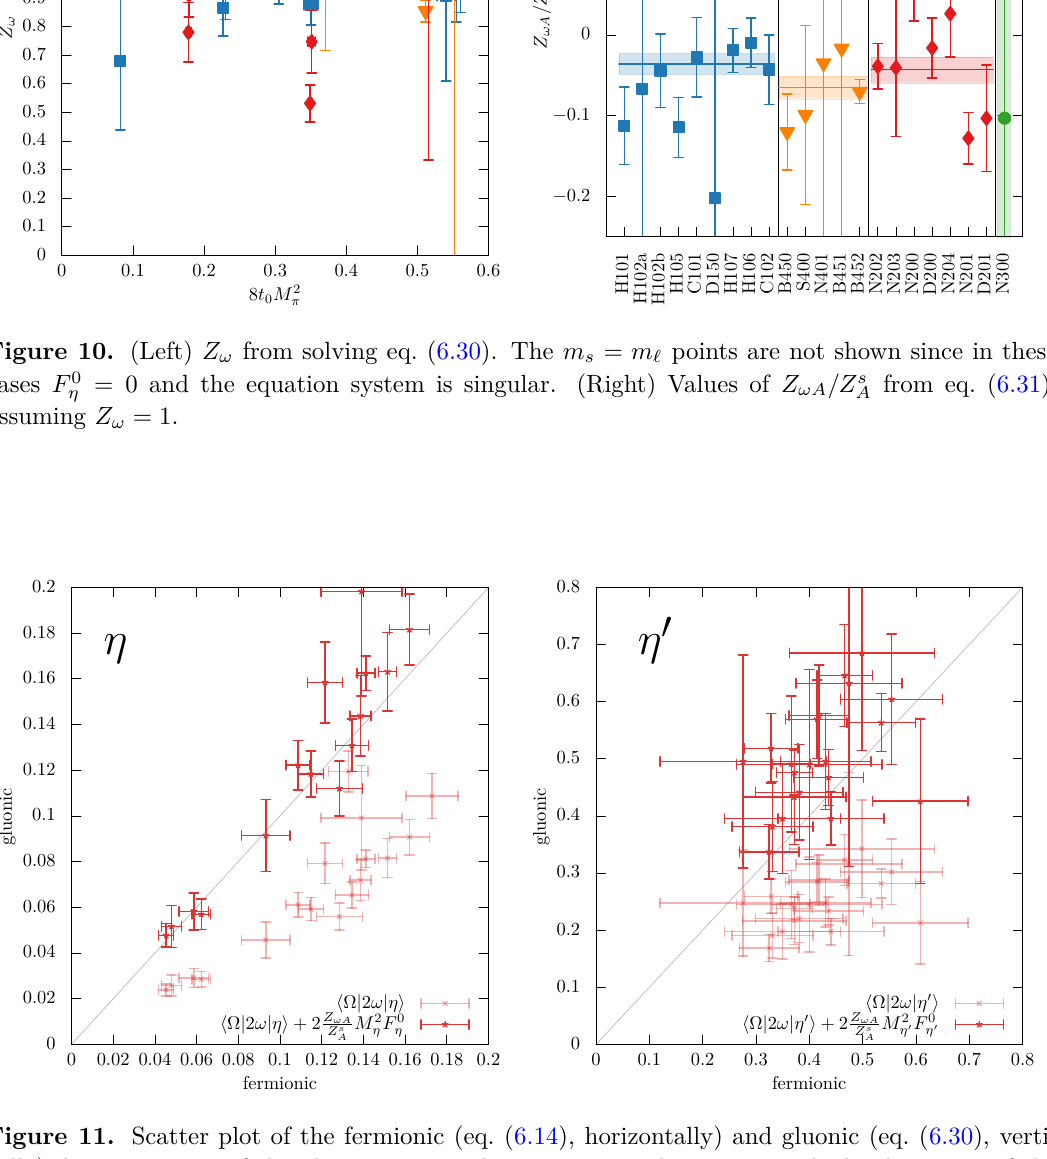
Figure 11. Scatter plot of the fermionic (eq. (6.14), horizontally) and gluonic (eq. (6.30), verti- cally) determinations of the gluonic matrix elements a η ( 0 ) . The mixing with the derivative of the axialvector current is non-negligible: the unrenormalized lattice matrix elements (pale red points) do not agree with the fermionic